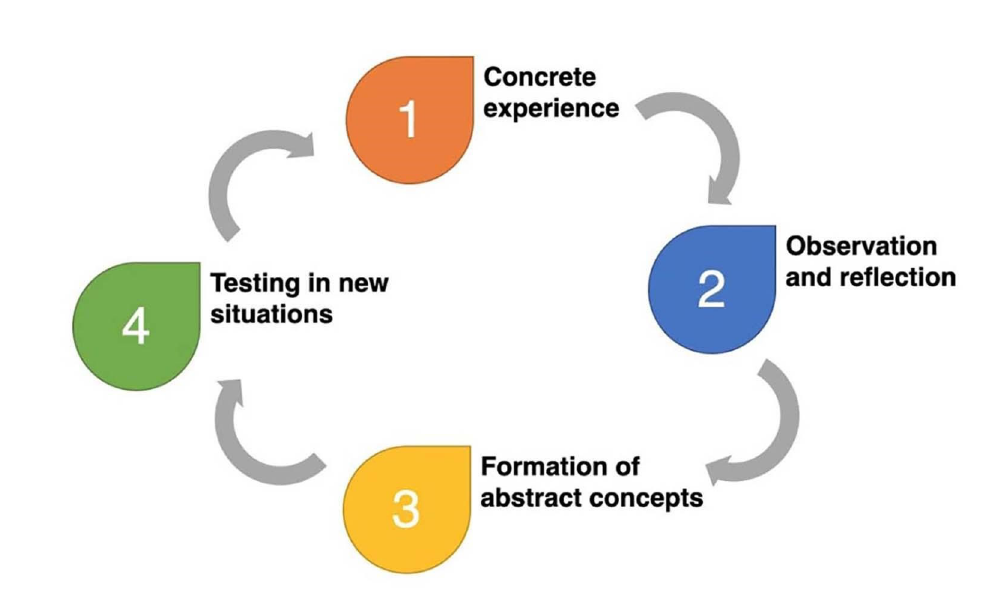
Figure 8 Visualization of Kolb’s experiential learning cycle (Source: Lohren Deeg, 2019, derived from Kolb). 21